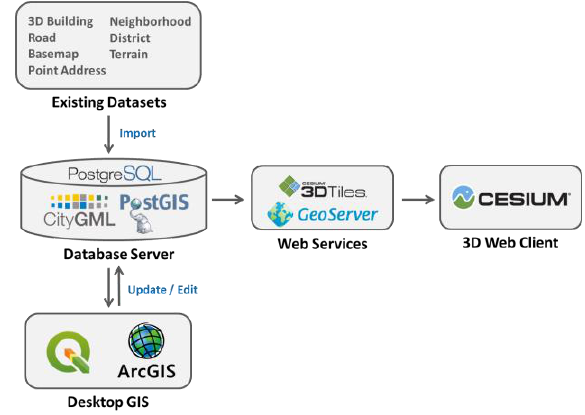
Figure 5. An integrated schematic diagram of the data flow (import, export, update, edit, retrieval, access) and the associated database schema for Istanbul 3D city models.